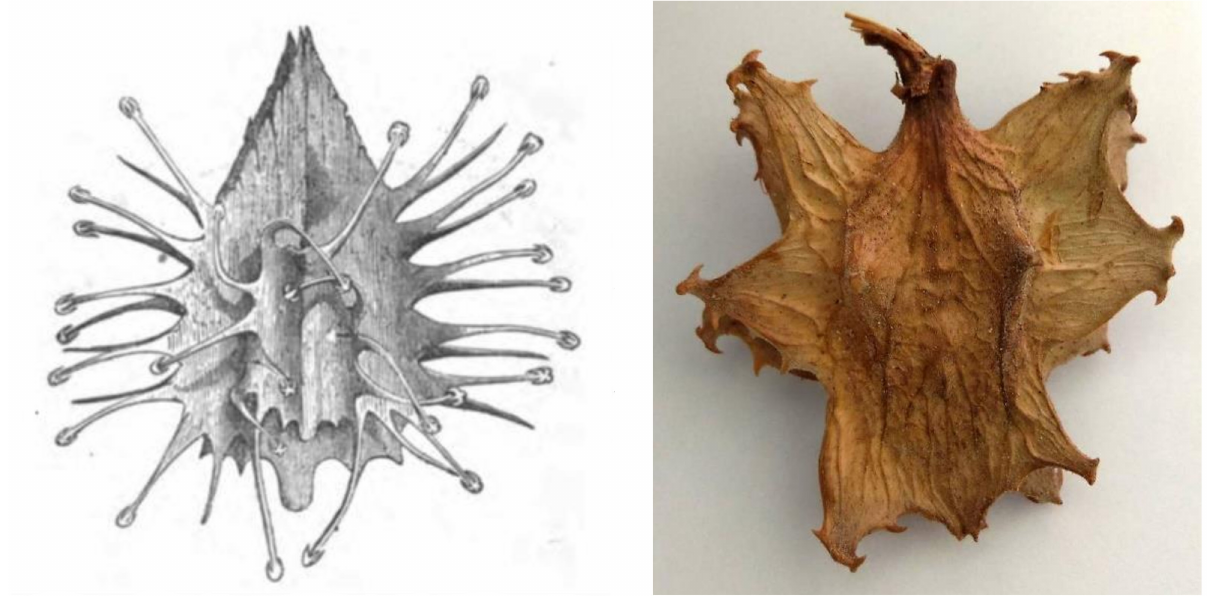
Figure 4. Fruit of the “Grapnel” (note the misspelling!) plant from [101] vs. an actual fruit (photograph by the author). Lübbert, in 1901, provided the first unambiguous account for the use of “Kuri- Khamiknollen” (= tubers of //khuripe//khams = Harpagophytum ) in wound healing